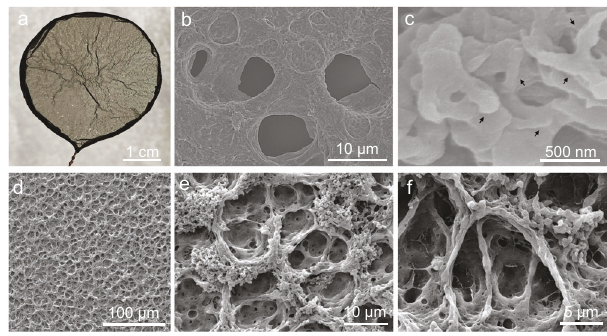
Fig. 5 PEI-PSSNa-CNT membranes prepared by SWOW. a An optical photograph, ( b , c ) SEM and ( d – f ) Cryo-SEM photographs of the PPCM1.5. Note: the CNT content in the hybrid membrane is 3